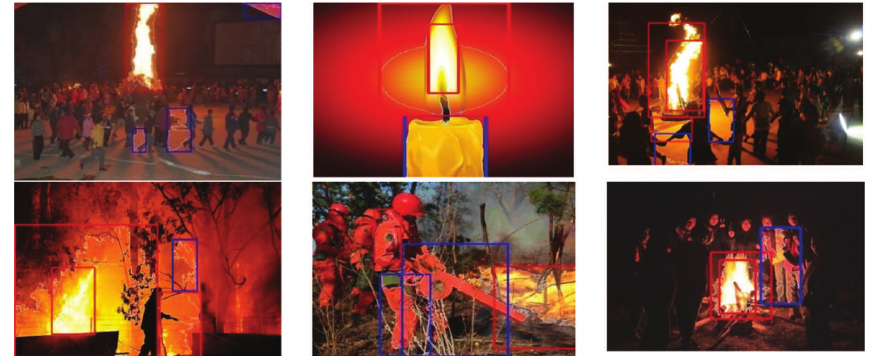
Figure 13: Region Whose Color is Mapped to Flame Color.